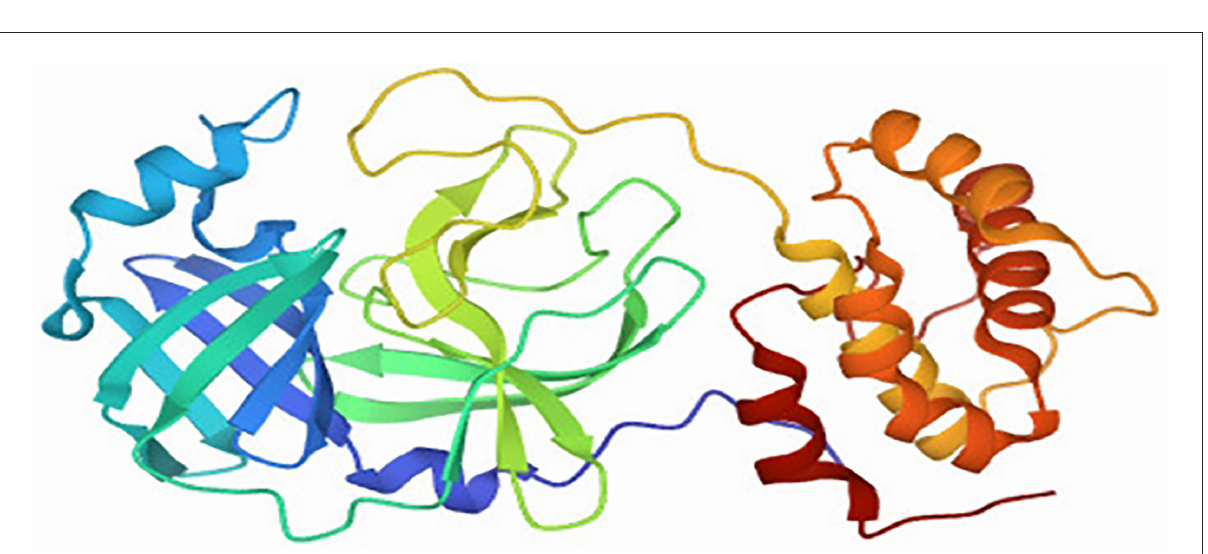
FIGURE6 Three-dimensional structure of 6LU7 main protease (Mpro): [PDB accession ID: 002214U].